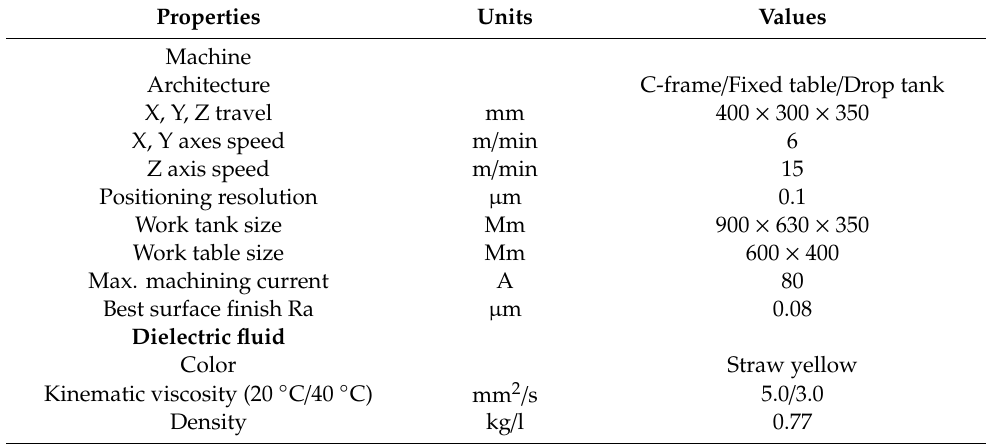
Table A2. Machine o dielectric fluid parameters.